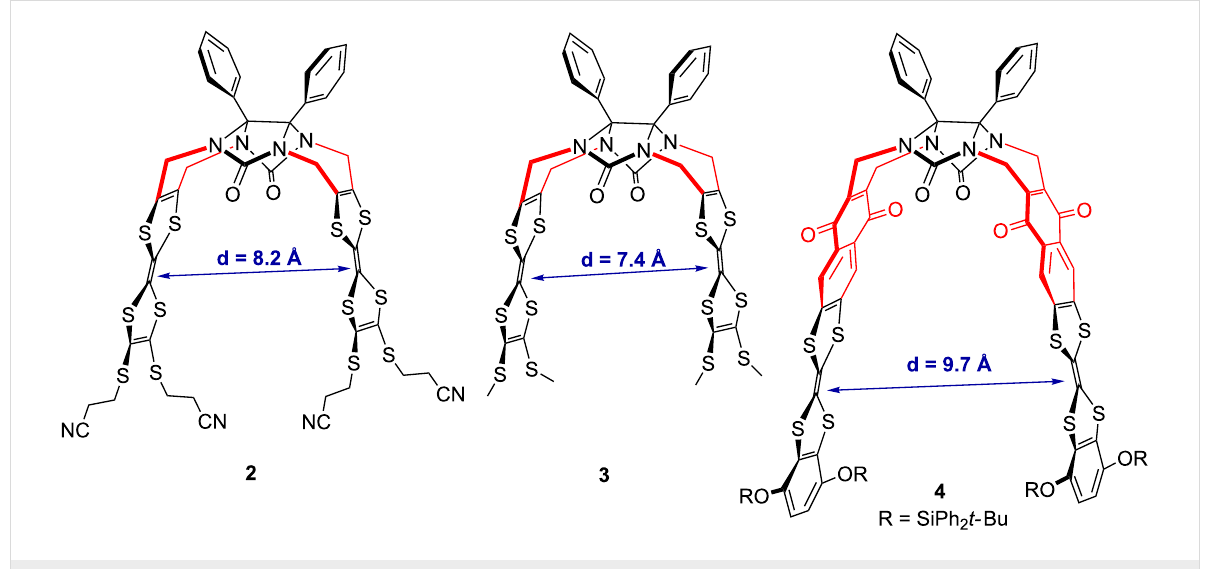
Figure 2: Intramolecular distances between TTF moieties from X-ray analysis for clips 2 and 3 and theoretical calculations for clip 4 .